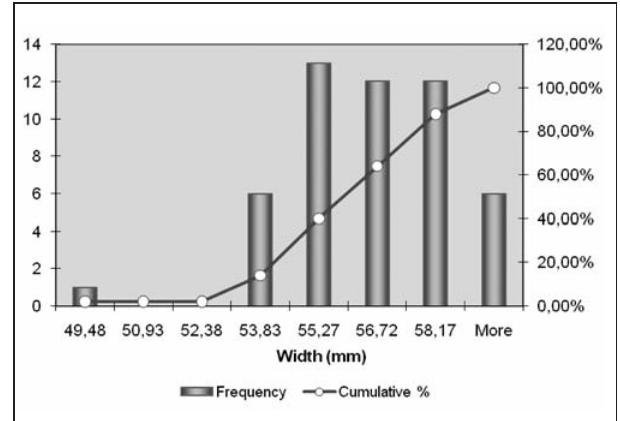
Fig. 38: Distribution of width values of category AAA of Late Jumbo apricot